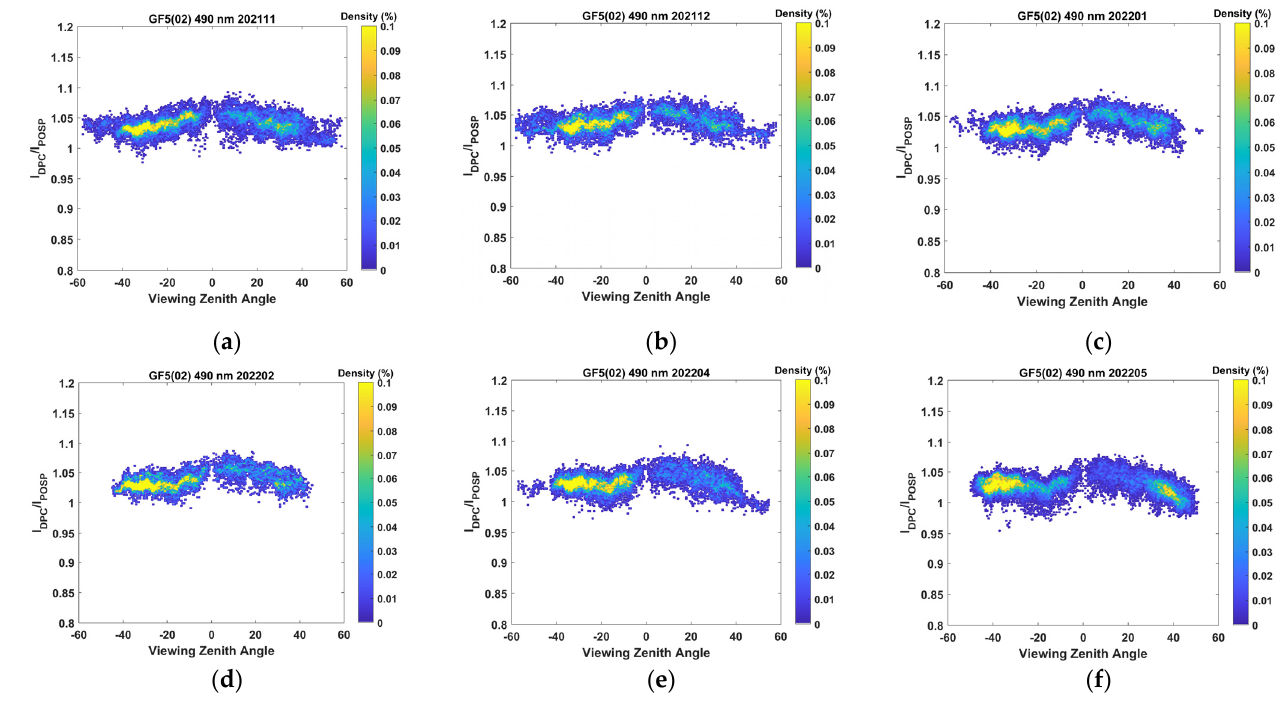
Figure 10. The ratio of DPC to POSP normalized radiance in the 490 nm band with different VZAs. These data pairs are selected for collection from ( a ) November 2021; ( b ) December 2021; ( c ) January 2022; ( d ) February 2022; ( e ) April 2022; and ( f ) May 2022 in DPC and POSP Level 1 products.